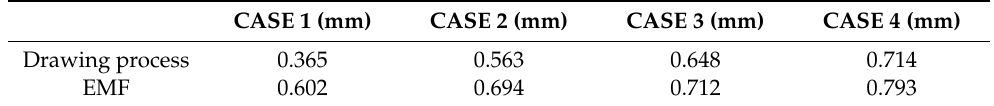
Table 6. Minimum thickness of each case.